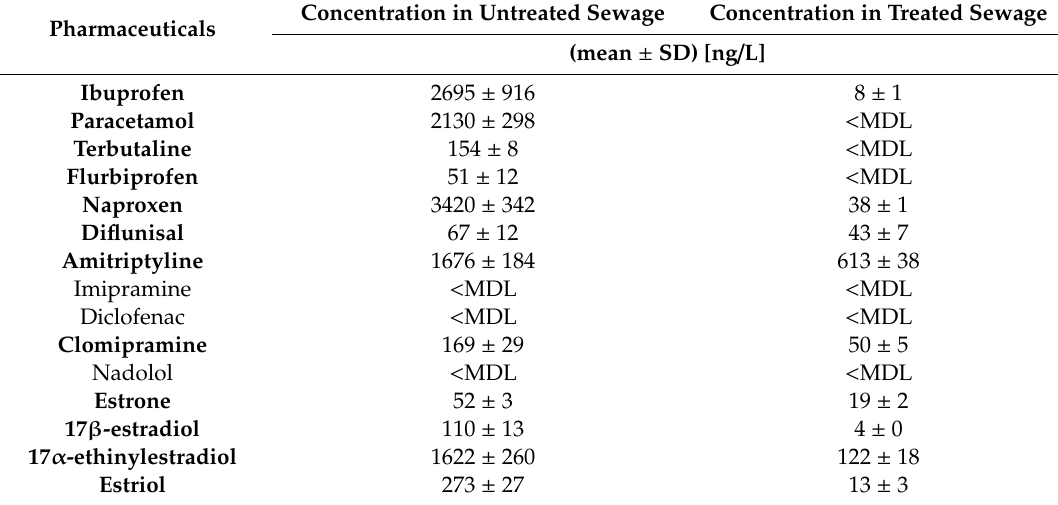
Table 1. Concentrations of target compounds in untreated and treated sewage samples collected from a municipal wastewater treatment plant (MWWTP), determined using the Solid-Phase Extraction (SPE)-GC-MS(SIM) method ( n =